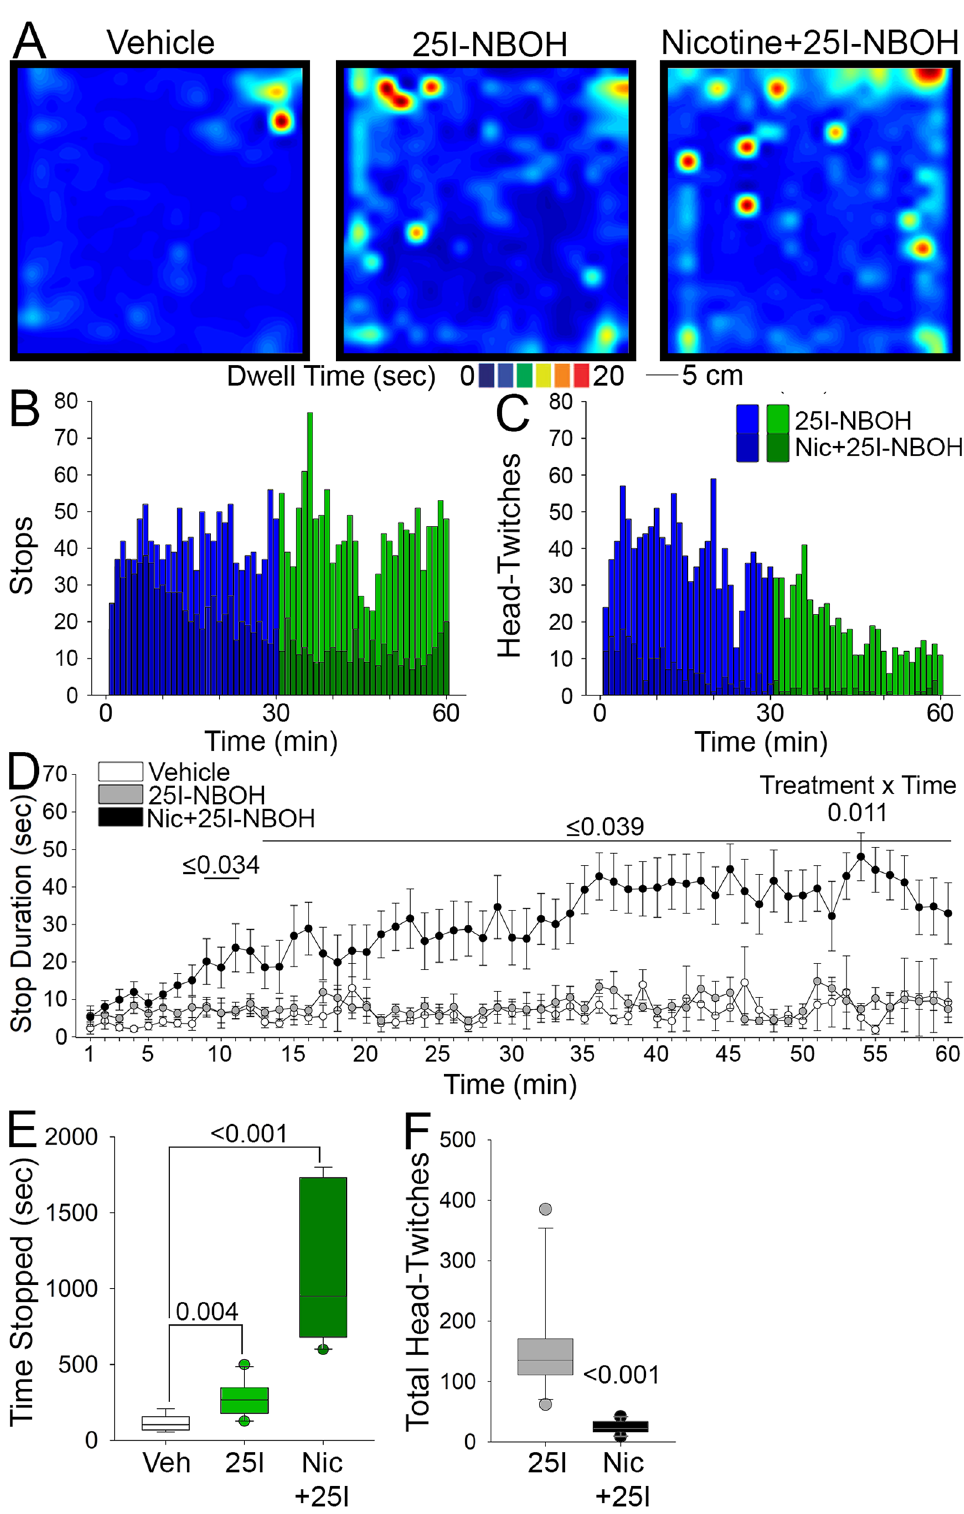
Figure 4. Behavioral arrest in the open field is increased after pretreatment with nicotine. ( A ) Representative heat maps for animals treated with vehicle (left), 1.429 µg kg −1 25I-NBOH (middle), and 2 mg kg −1 nicotine in the open field. ( B ) Plot of the cumulative stops made in the open field by nicotine pretreated animals (superimposed dark blue and green) compared to 25I-NBOH treatment alone (bright blue and green). ( C ) Plot of the cumulative head-twitches made by nicotine pretreated animals (superimposed dark blue and green) compared to 25I-NBOH treatment alone (bright blue and green). ( D ) Line plot of duration of stops made during the 60 min testing period, comparing vehicle, 25I-NBOH and nicotine + 25I-NBOH treated animals. ( E ) Comparison of the time stopped in the open field for vehicle, 25I-NBOH, and nicotine + 25I-NBOH treated animals during the 30–60 min time period. ( F ) Total number of head-twitch for 25I-NBOH and nicotine pretreated animals. Details of the experimental design and statistical analyses, including numbers of animals, mean ± SE, main effects and p values, can be found in Sup. Table